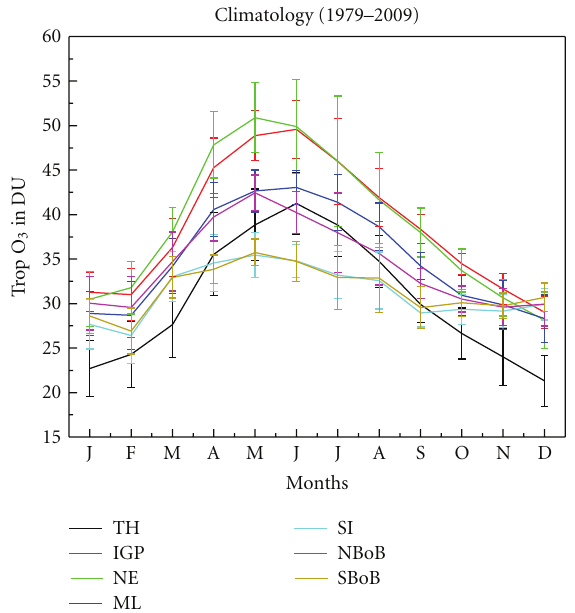
Figure 2: Month-to-month variation of tropospheric column ozone measured by TOMS and OMI satellites over TH, NE, IGP, ML, SI, NBoB, and SBoB averaged for the period 1979–2009. The vertical bars represent the standard deviation from the mean.